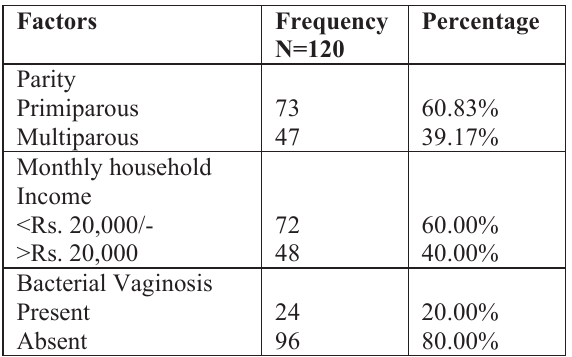
Table-2: Frequency and percentage of factors in